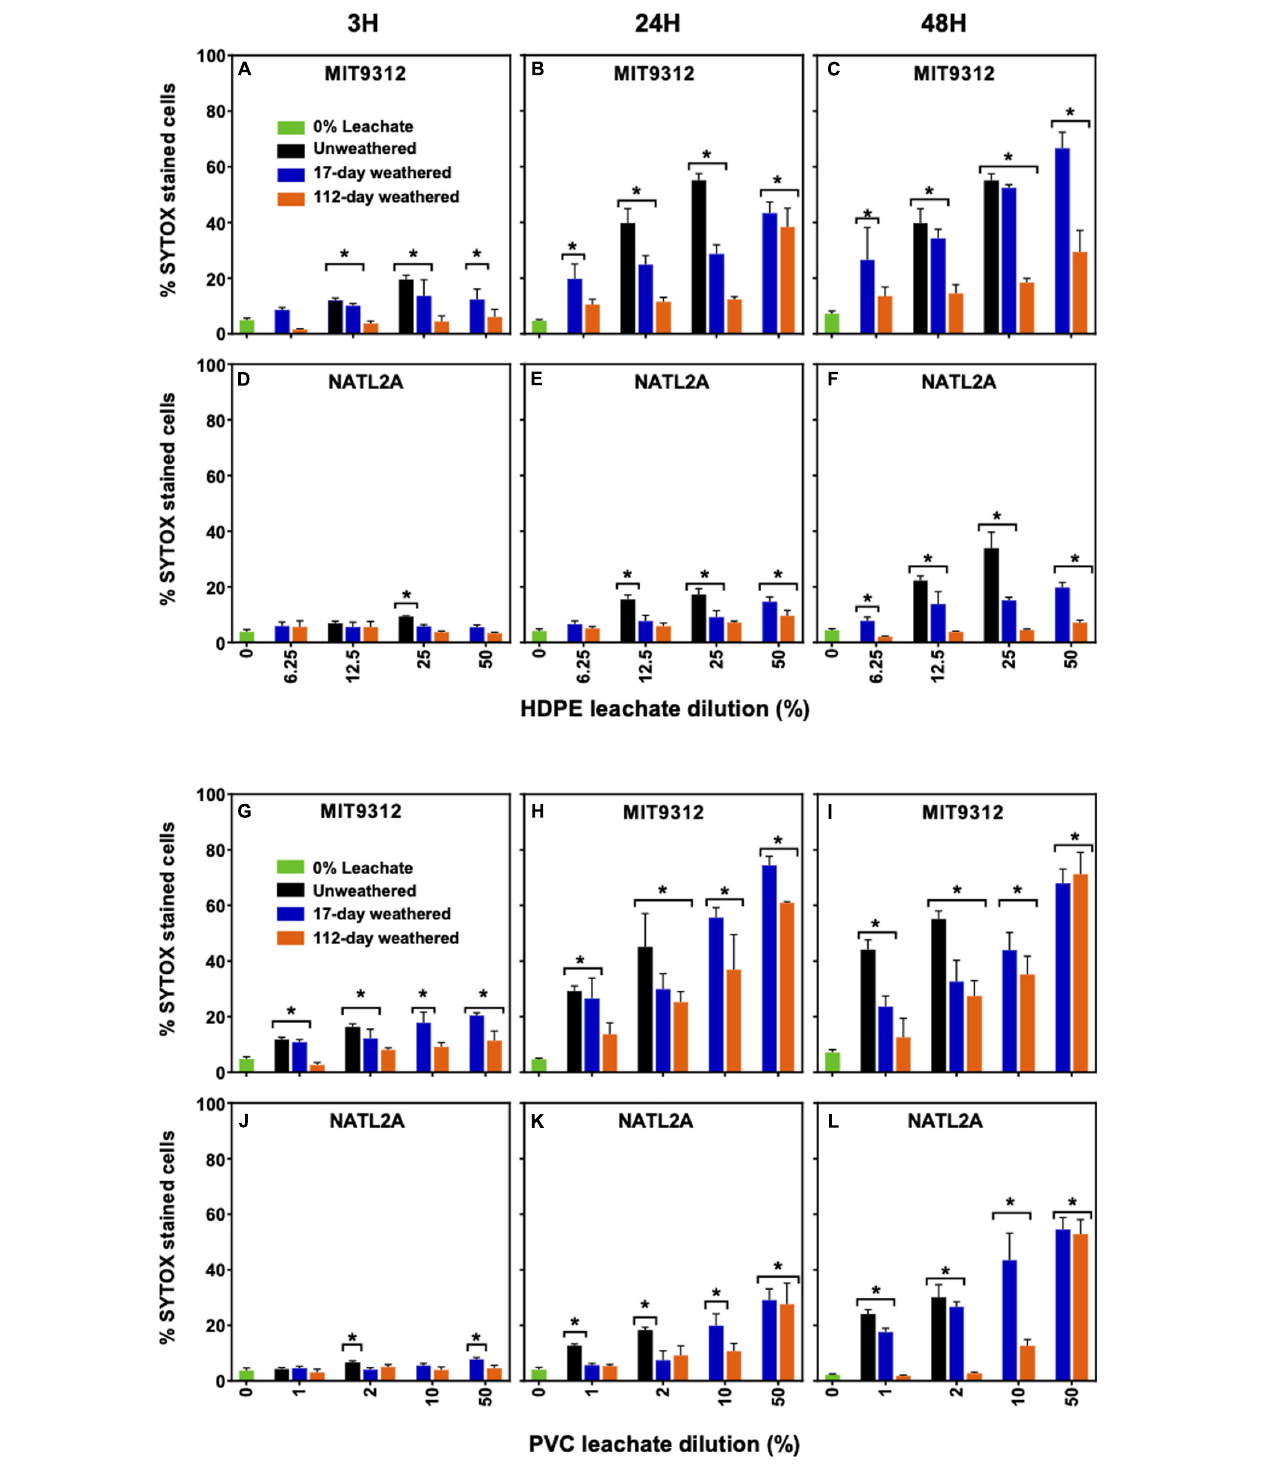
FIGURE 4 | SYTOX Green stained (i.e., membrane compromised) populations after exposure to different dilutions of weathered HDPE leachates in Prochlorococcus (A–C) MIT9312, (D–F) NATL2A and PVC leachates in Prochlorococcus (G–I) MIT9312, (J–L) NATL2A. Leachate from HDPE and PVC weathered for 17-days in blue bars, weathered for 112-days in orange bars, unweathered in black bars. Zero leachate control are represented by green bars. Column height corresponds to mean ± standard deviation values of the biological replicates ( n = 4 for all except unweathered where n = 3). Asterisks (*) are used to signify data points where measurements were significantly ( p < 0.01) different compared to the 0% leachate control at each time point to eliminate the small changes in % SYTOX stained cells for the control.